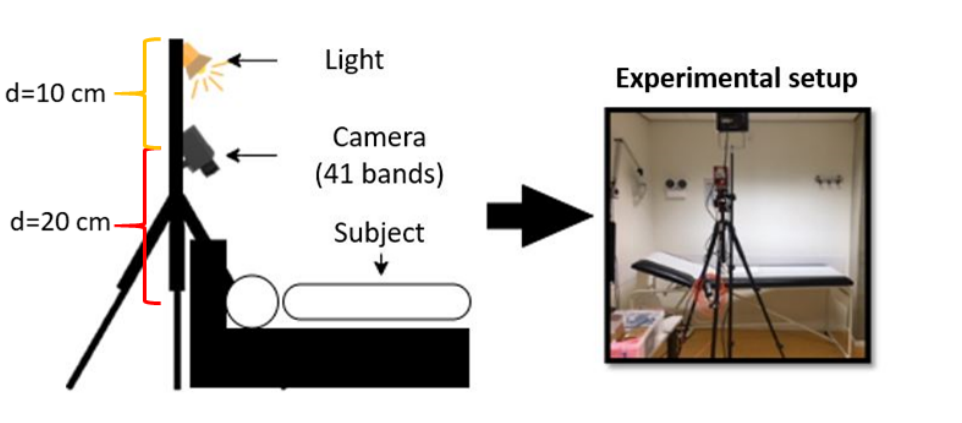
Figure 3. Schematic view of the hyperspectral acquisition set-up, consisting of a light source, a 41-channel hyperspectral camera and an exam